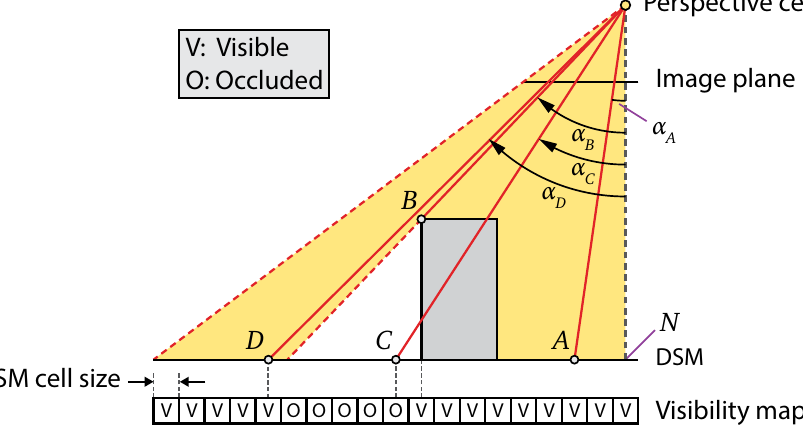
Figure 6. Principle of occlusion detection using the angle-based